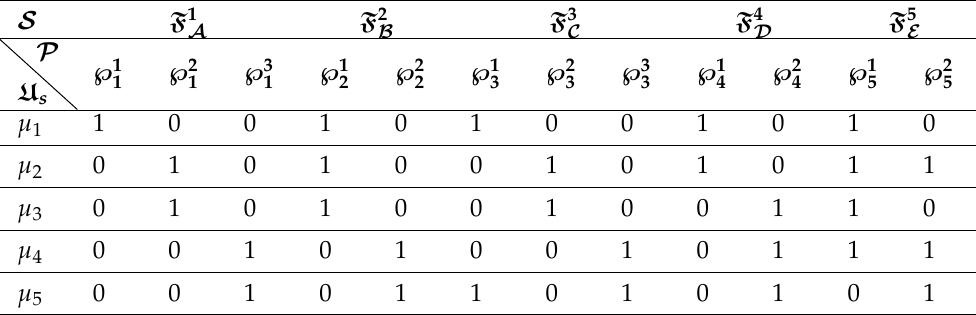
Table 1. Table of defined Soft sets over U s